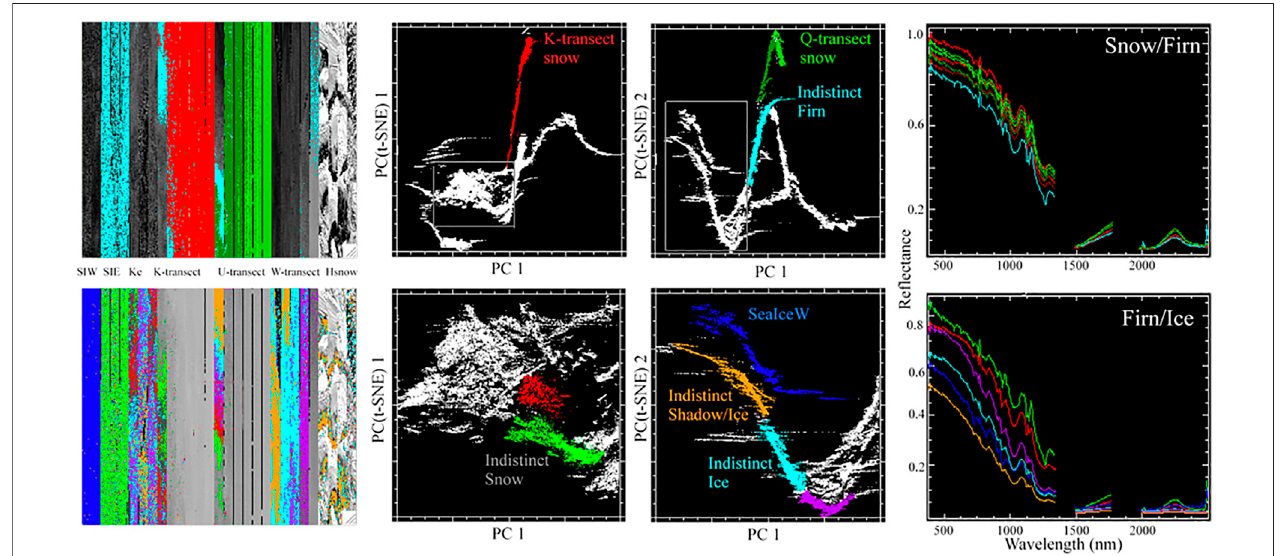
FIGURE 5 | Continuous distinct snow- fi rn gradients and discontinuous indistinct fi rn-ice distributions. In the multiscale PC + PC(t-SNE) feature spaces, snow gradients on the eastern K and Q transects (top) have similar re fl ectance with very little change in amplitude but form distinct clusters (labeled as solid colors) in the PC(t-SNE) dimensions. However, the separate cluster corresponding to indistinct fi rn (cyan) represents much of SeaIceE and parts of all three transects. Clusters from enlarged subspaces (bottom) span amuch wider range oflower re fl ectances but all except SeaIceW (blue) are present in at least two locations and each transect contains at least three indistinct re fl